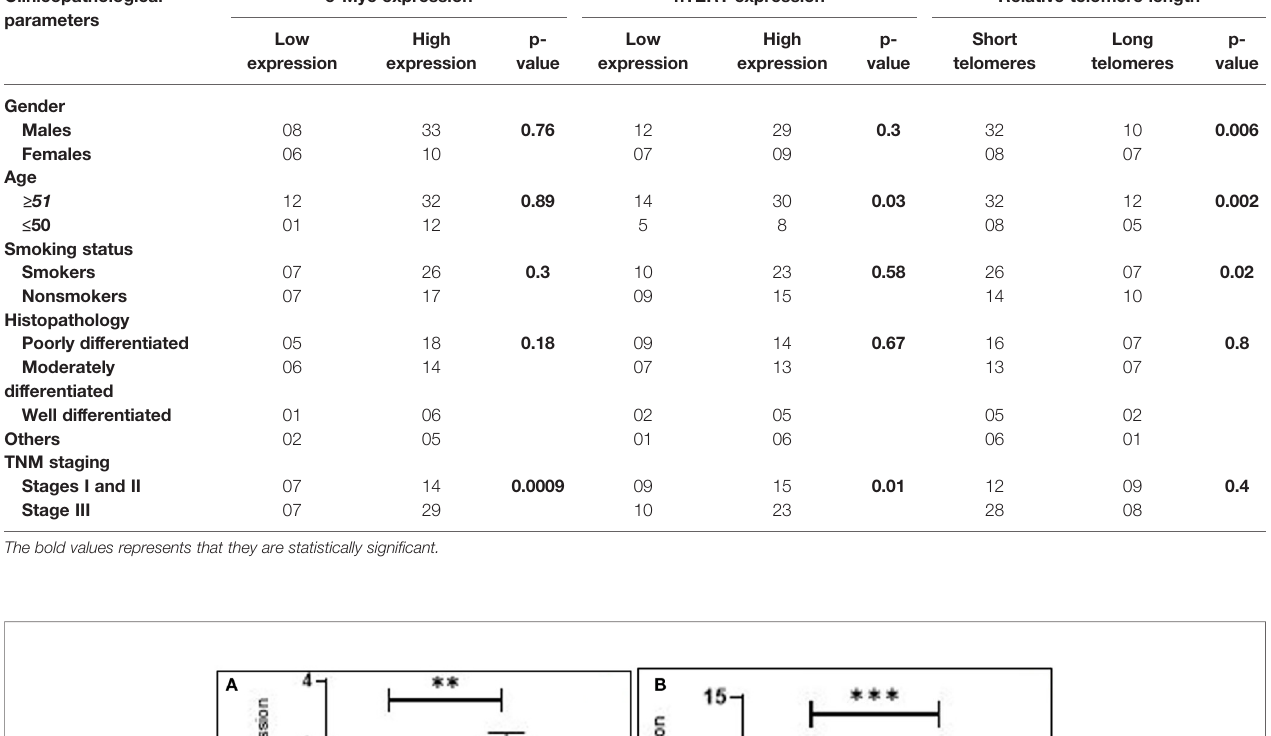
TABLE 2 | Association of c-Myc, hTERT expression, and relative telomere length with different clinicopathological fi ndings in gastric cancer patients. Clinicopathological parameters